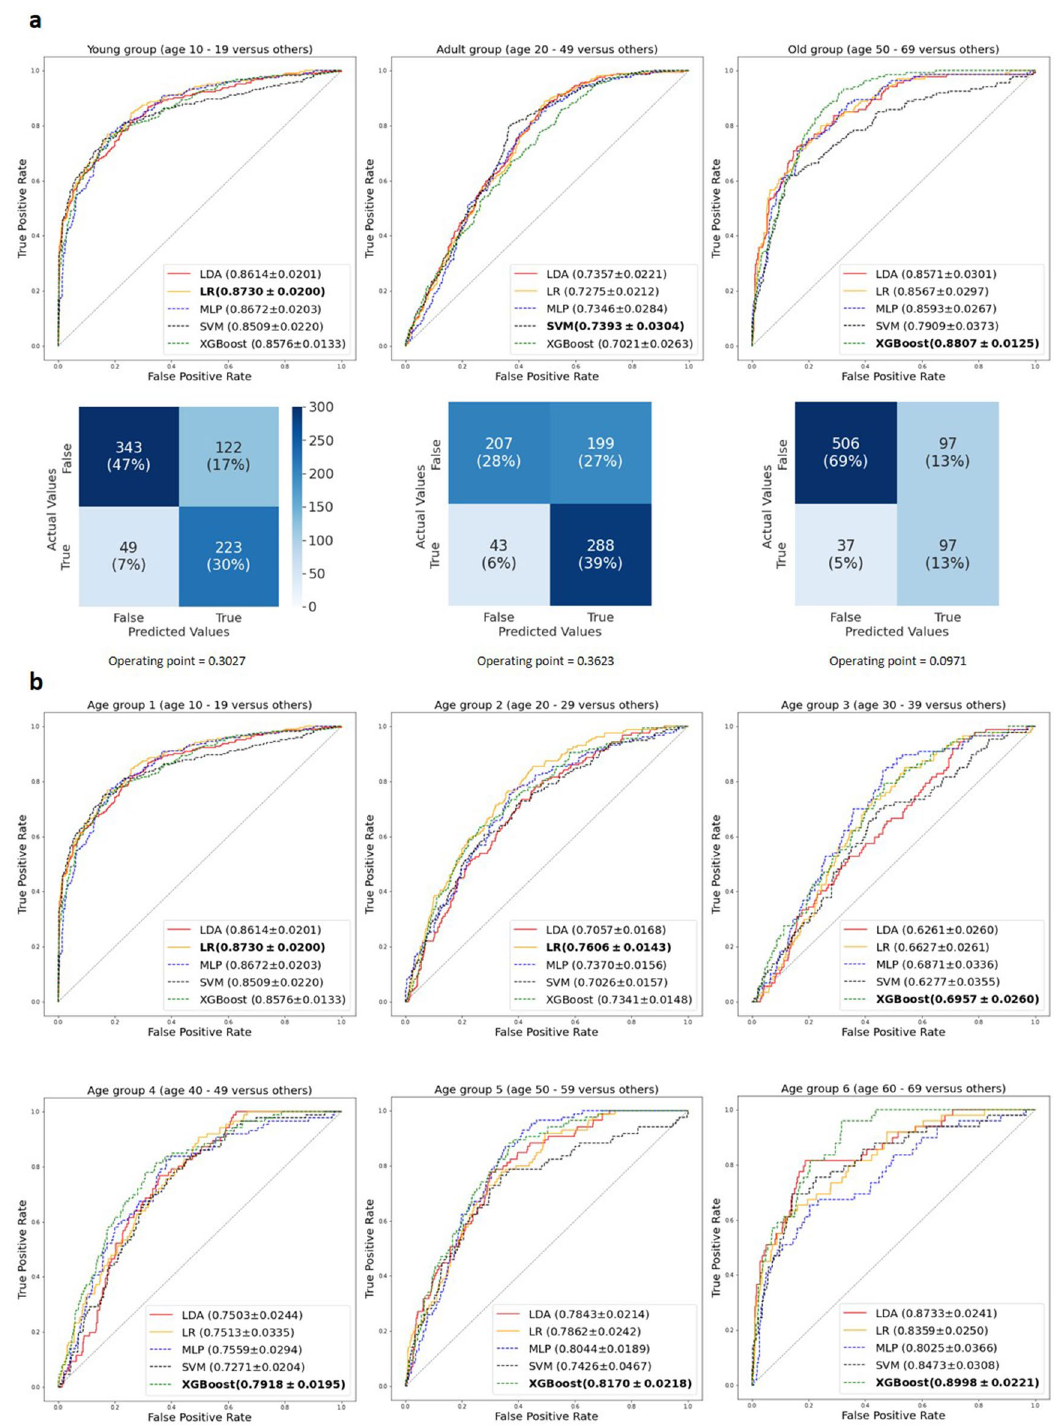
Figure 2. Prediction results of each age groups. ROC curves with the mean AUCs and standard errors of the folds of the five models and confusion matrices in the three age-group classifications ( a ) and ROC curves of six age-groups case ( b ). The bold text in each curve plot represents the model with the best score (mean